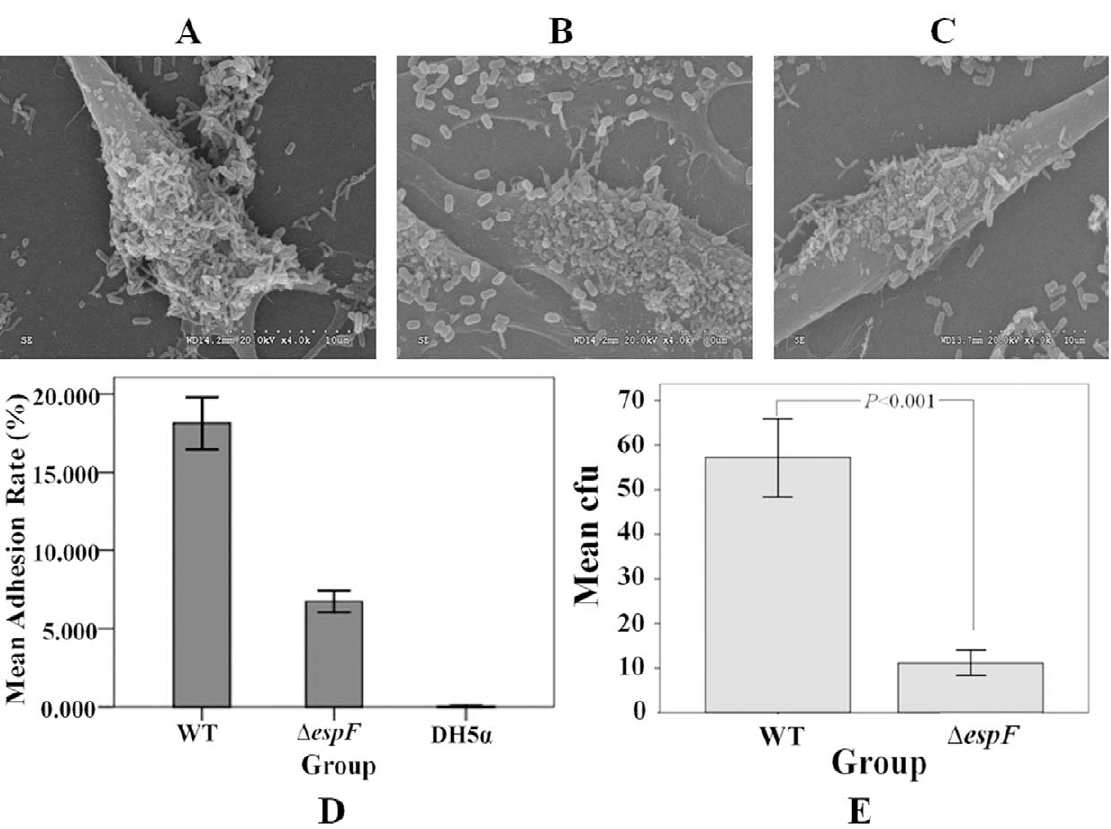
Figure 1. Adhesive ability of EHEC O157:H7 with Lovo cells under electron microscopy. (A) Lovo cells infected with EHEC O157:H7 wild type (WT) strain. (B) Lovo cells infected with EHEC O157:H7 espF -deficient mutant ( D espF ) strain. (C) Lovo cells infected with E. coli DH5 a . (D) Mean adhesion rate of Lovo cells infected with wild type, D espF , and DH5 a groups; results show mean 6 SD (n=3). (E) Mean cfu of Lovo cells infected with wild type and D espF ; results show mean 6 SD (n=3); P , 0.001 for all groups.